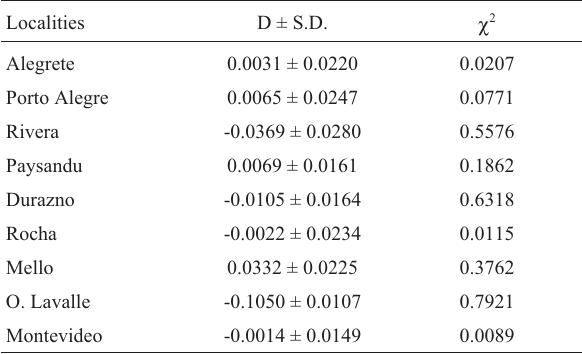
Table 4 - Linkage disequilibrium coefficients (D ± S.D.) between Mdh-1 and Hk-1 loci in samples of Apis mellifera workers from southern Brazil and